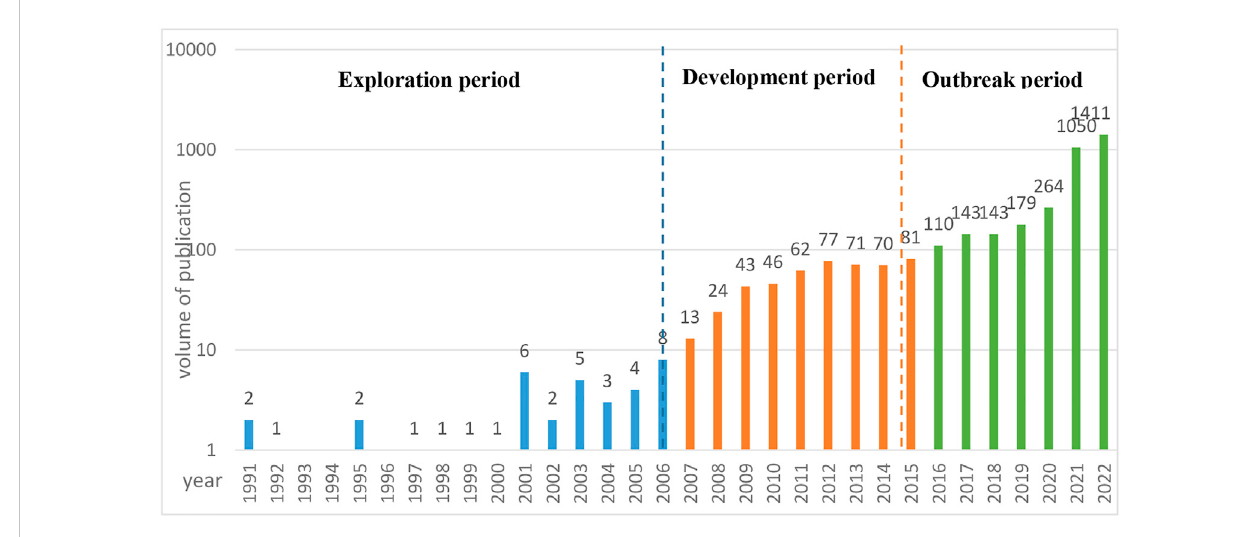
FIGURE 1 Statistics on the volume of publications on carbon peaking and carbon neutrality from 1991 to